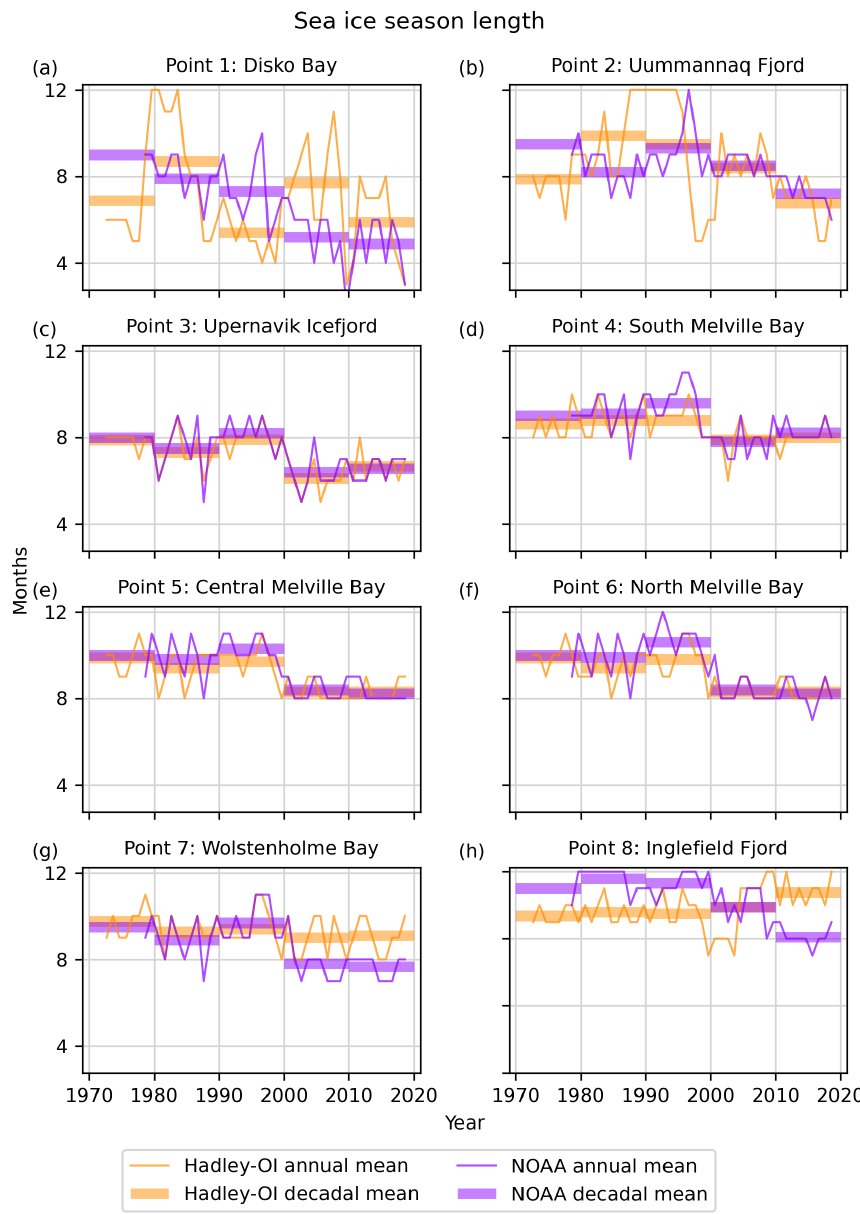
Figure 9. Annual duration of sea-ice season (when sea-ice concentration is greater than 15%) from Hadley-OI (orange) and NOAA (purple). Each panel corresponds with an ocean point in Fig.